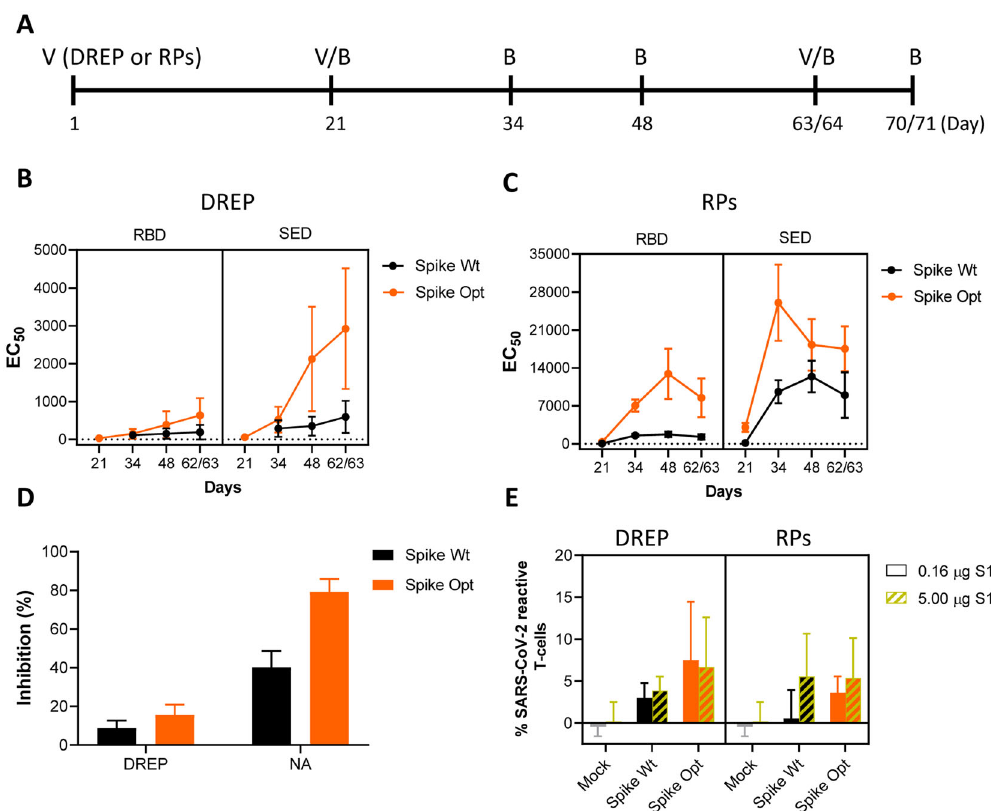
Fig. 3 Immunogenicity of vaccine candidates in a guinea pig model. A Timeline of animal handlings. V = vaccination with plasmid DNA- launched replicon RNA (DREP) or VEEV replicon particles (RP), B = blood sampling. B , C Indirect ELISA performed using SARS-CoV-2 S RBD (left) or S ectodomain (right) as capturing antigens. Shown are the EC 50 values of sera (expressed as fold dilution) from guinea pigs exposed to the wildtype S antigen (Spike Wt) or the optimized S antigen (Spike Opt). D SARS-CoV-2 surrogate virus neutralization (VN) assay performed using 1.000-fold diluted serum samples collected after prime-boost vaccination at day 34 and expressed as percent inhibition. E Results of lymphocyte stimulation test (LST) using blood collected on day 70/71. Puri fi ed SARS-CoV-2 S1 antigen was used to stimulate isolated lymphocytes and proliferation was measured 96 h post-stimulation. Gating-procedure in Supplementary Fig.